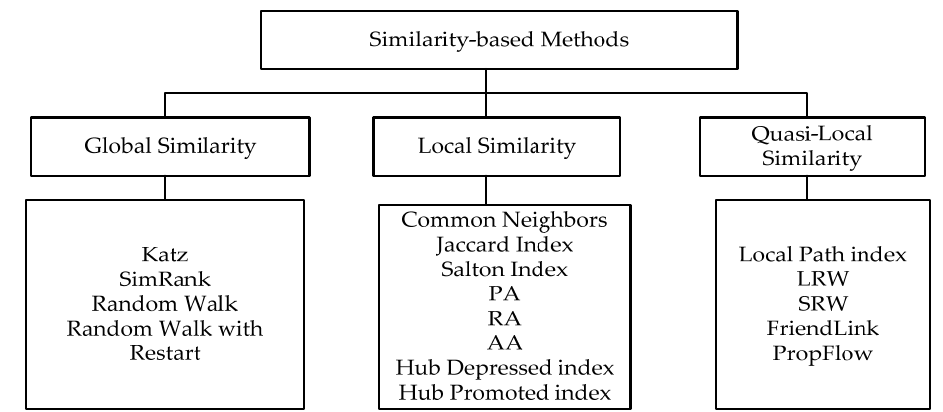
Figure 8. Similarity-based methods.